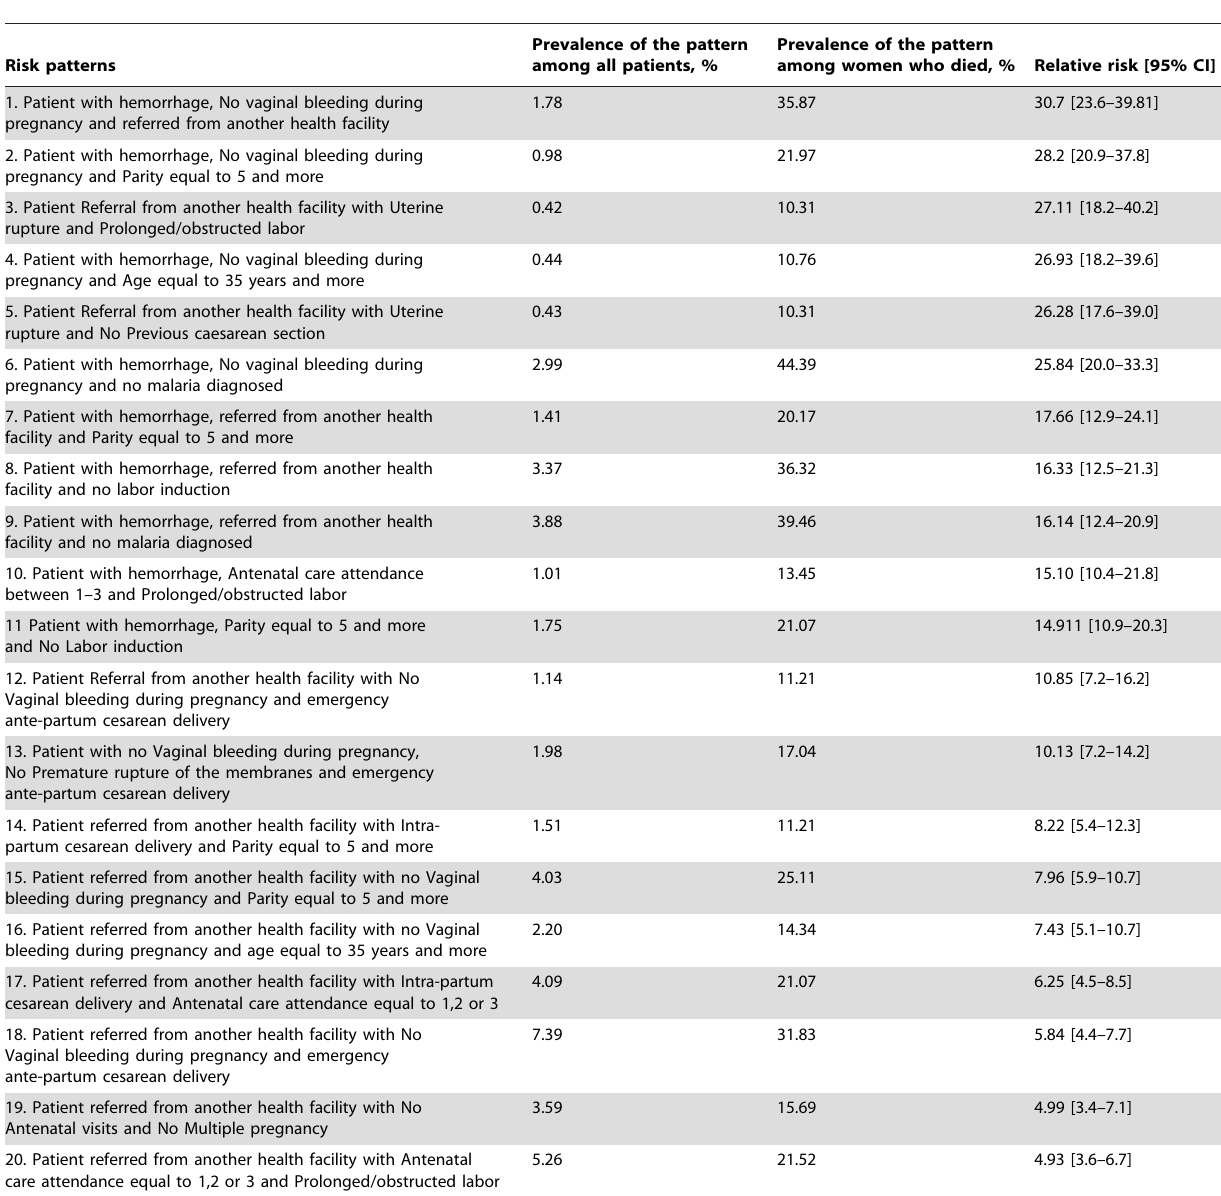
Table 2. Classification association rule predicting in-hospital maternal mortality* among patients delivering in 46 hospital in Senegal and